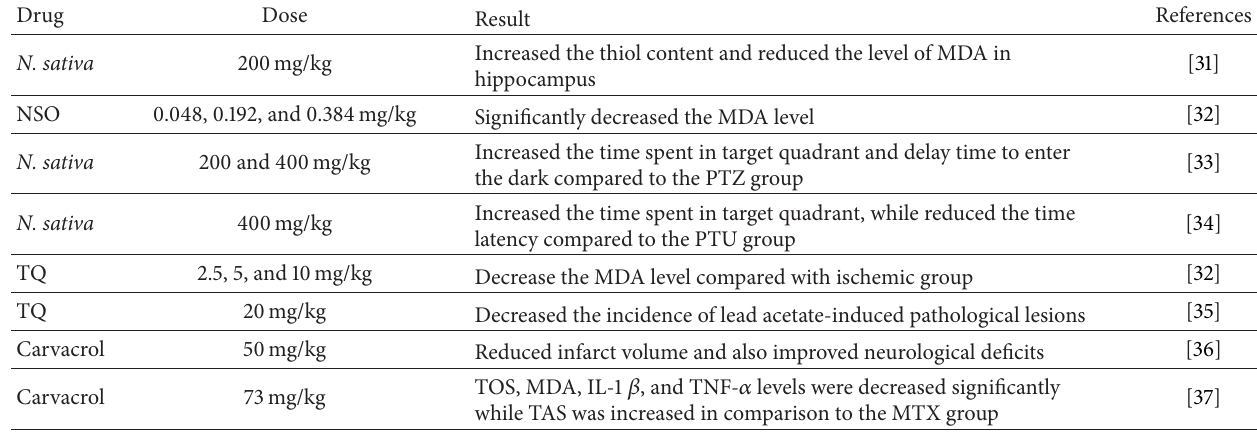
Table 5: The protective effect of Nigella sativa and its constituents on oxidative